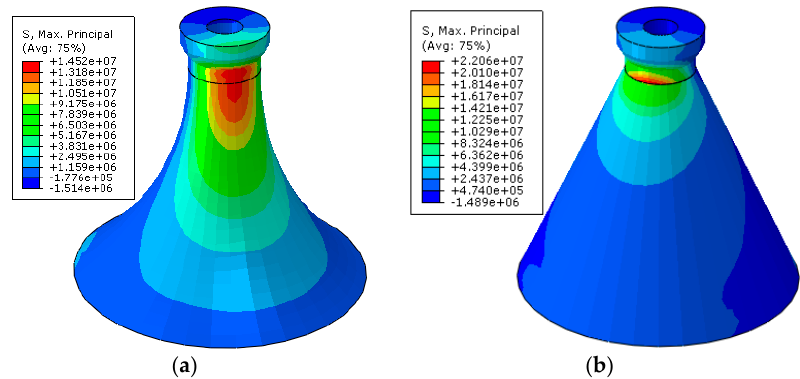
Figure 6. Stress transfer of the non-pre-stressed part. Stress transfer of the pre-stressed part: ( a ) Arc type; ( b ) Line type.